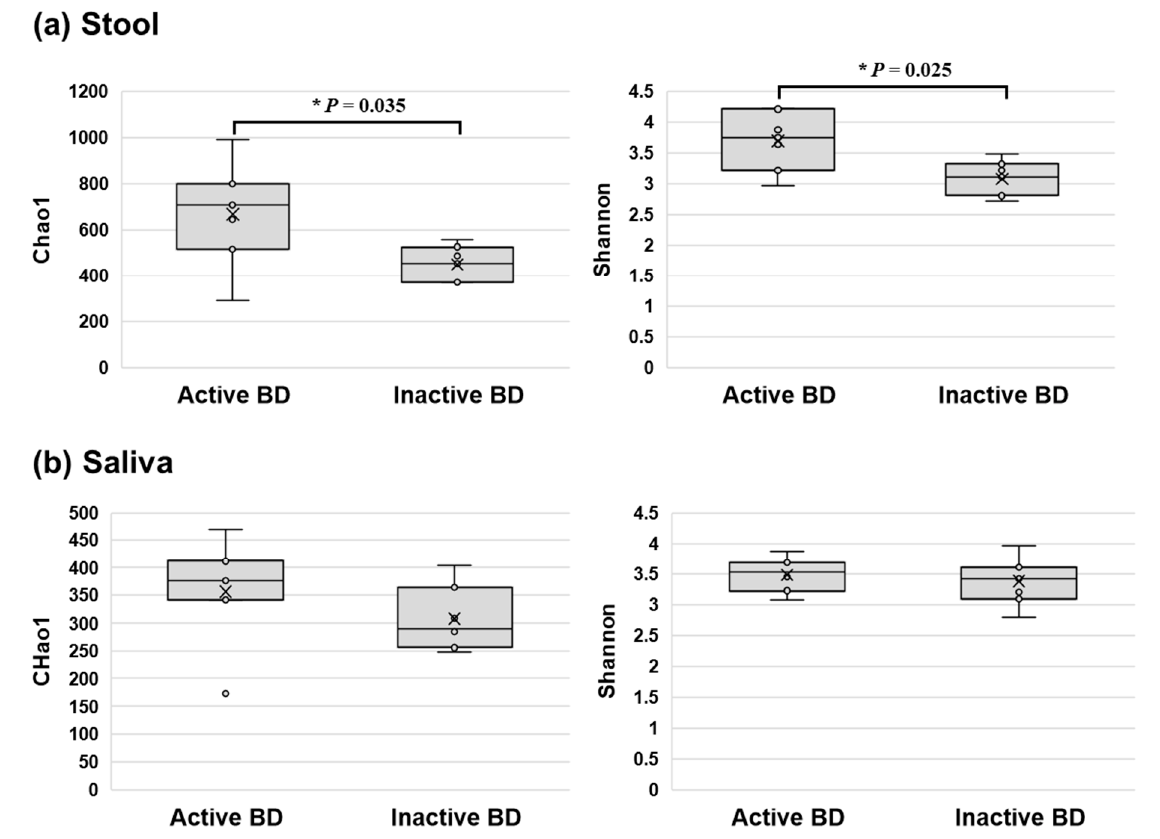
Figure 6. Comparison of the taxonomic alpha diversities of microbiomes in the active and inactive BD groups. The alpha diversity scores calculated using the Chao1 and Shannon diversity indices in the stool ( a ) of the active BD group were significantly higher than those of the inactive BD group ( p = 0.035 and p = 0.025, respectively). However, in salivary samples ( b ), no difference in alpha diversity indices was observed between the two groups. BD, Behçet’s disease.